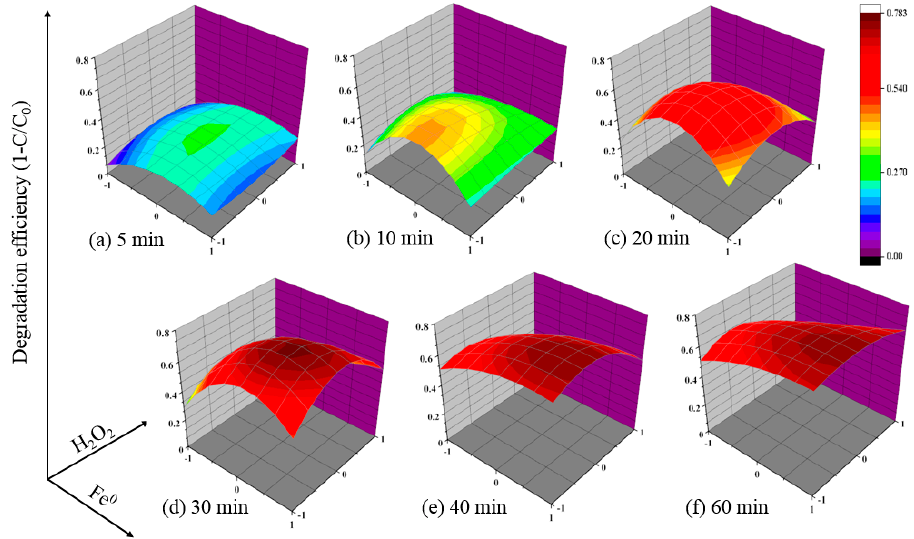
Figure 2. 3D response surfaces from Equations